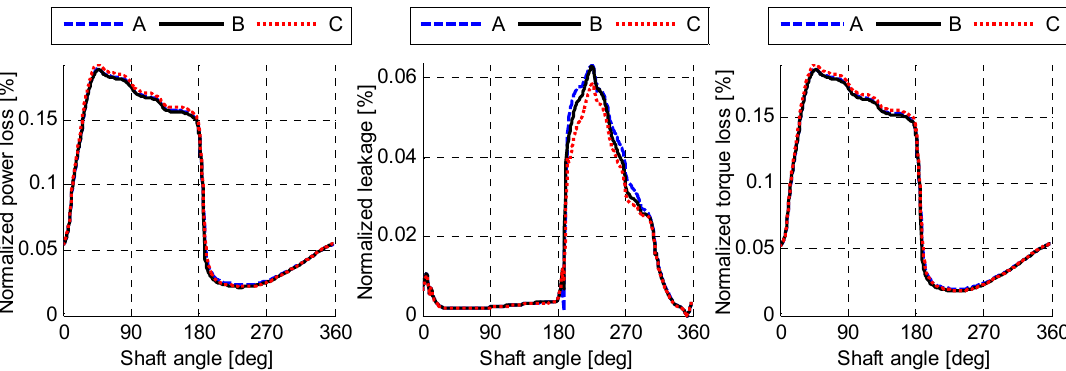
Figure 12. Normalized slipper/swashplate interface energy dissipation comparison for different sizes.